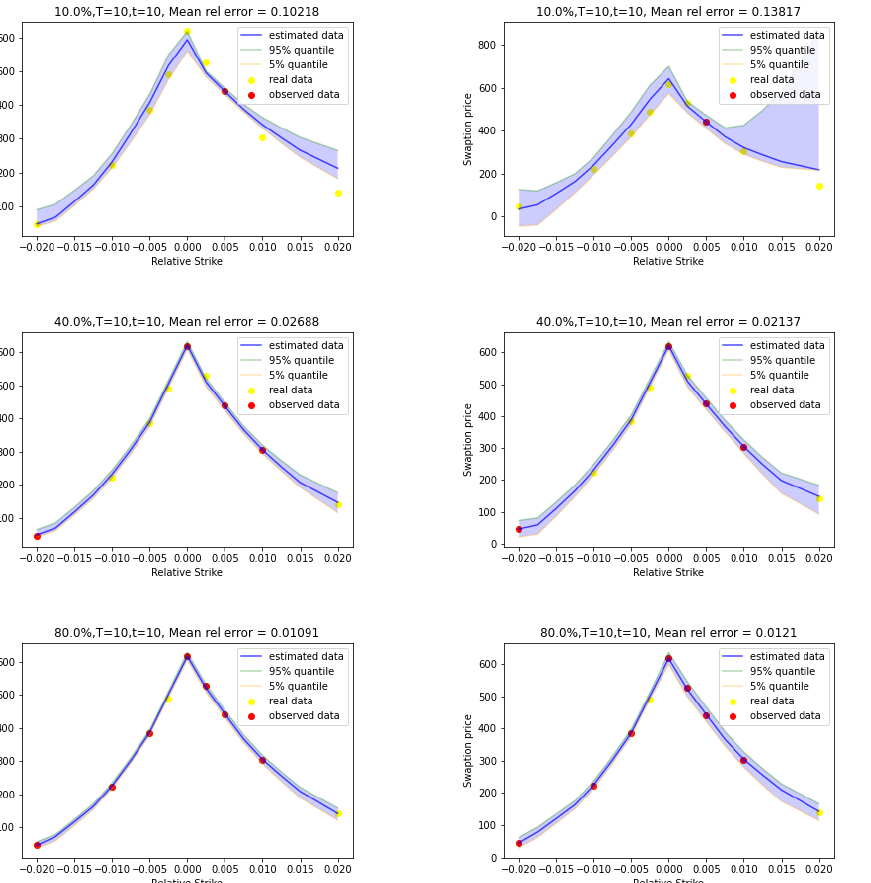
Figure 2. Constrained GP ( left ) and unconstrained GP ( right ) price curves with uncertainties for p = 10% ( top ), p = 40% ( middle ) and p = 80% ( bottom